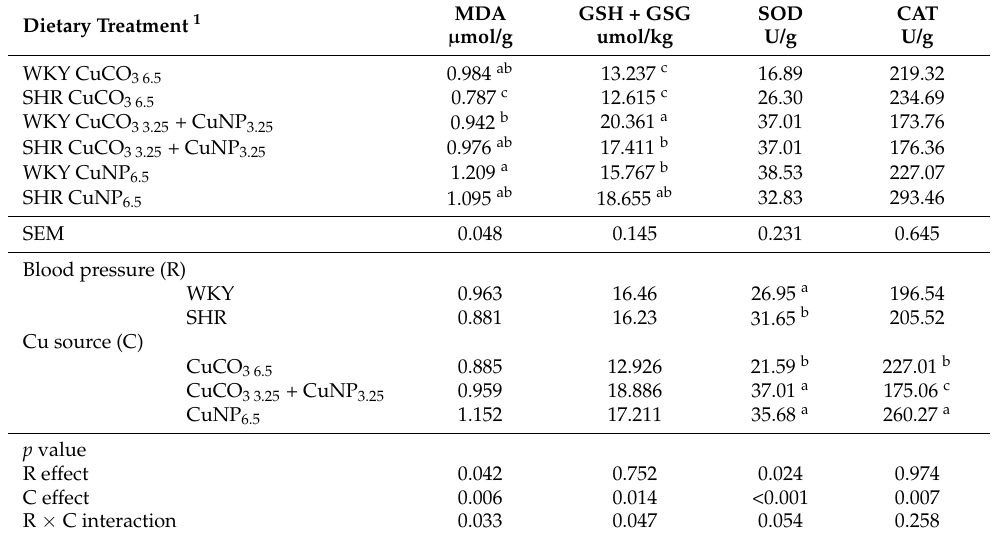
Table 2. Redox status in heart